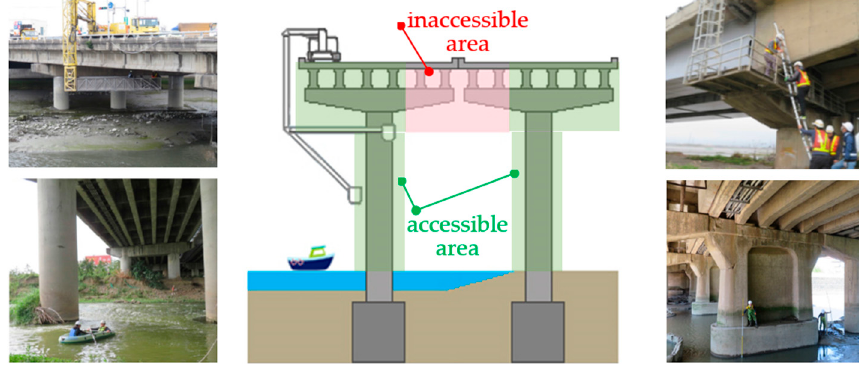
Figure 1. Traditional bridge inspection operations (bridge inspection equipment).